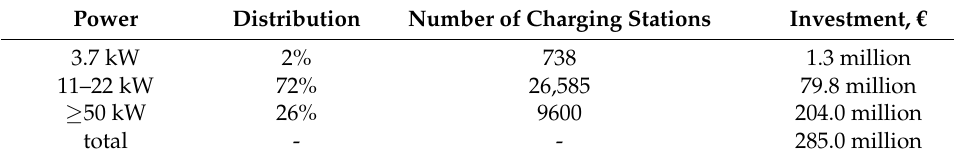
Table 3. Total investment of public charging points in the Stuttgart area [26].